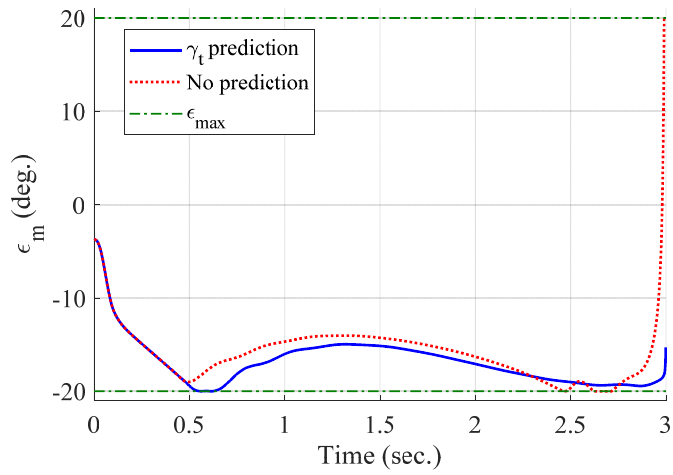
Figure 7. Look angle of the missile (single-run simulation).